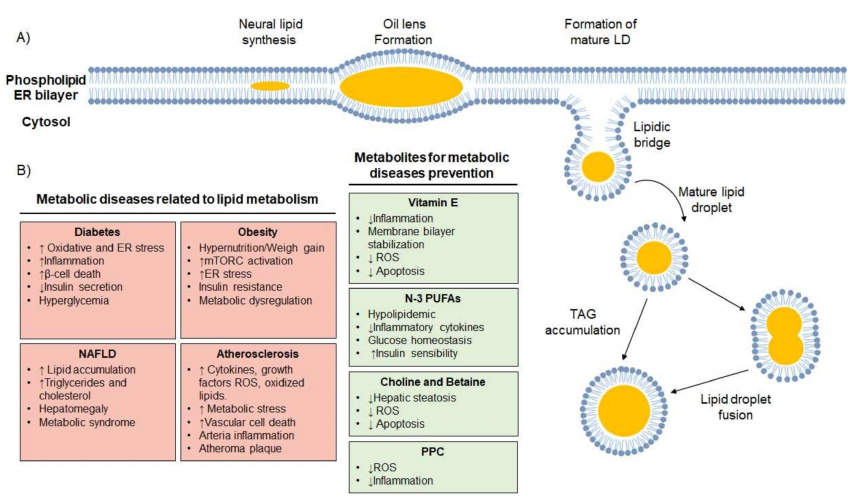
Figure 3. ( A ) Lipid droplet synthesis. Neutral lipids are synthesized into the endoplasmic reticulum (ER) and accumulate between leaflets to form lipid lenses. Lipid accumulation deforms the ER until the lipid droplet (LD) buds from the ER to cytosol. LDs can increase its size by fusion with other LDs or TAG local accumulation. ( B ) Relevant metabolic diseases associated with increased lipid metabolism and lipids with a beneficial e ff ect on metabolic